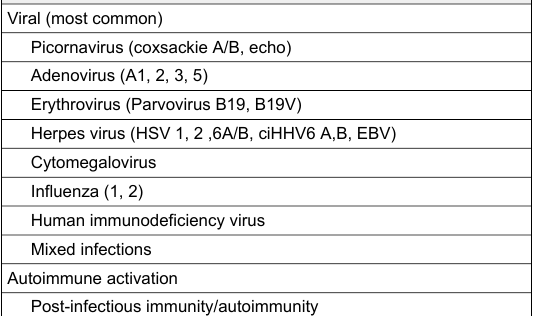
Table 1: Frequent viruses causing infectious and post-infectious myocarditis. Viral (most common) Picornavirus (coxsackie A/B, echo) Adenovirus (A1, 2, 3,